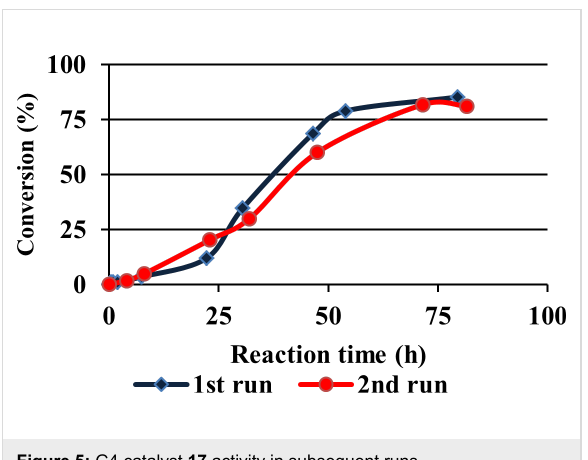
Figure 5: G4 catalyst 17 activity in subsequent